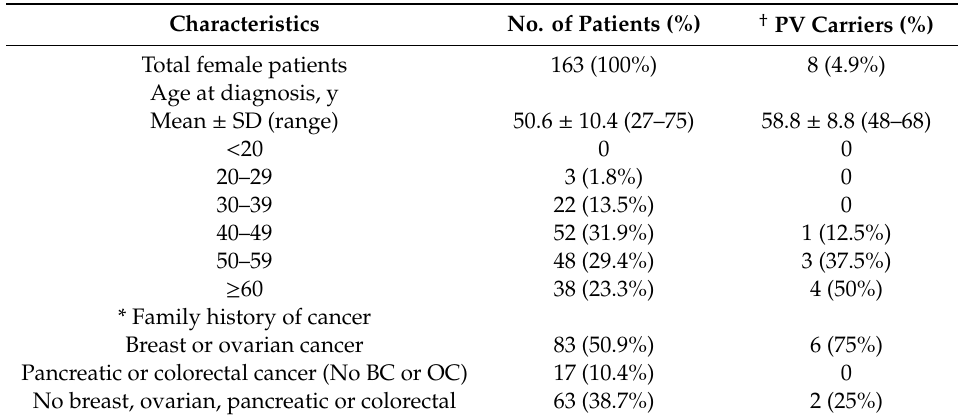
Table 2. Study population